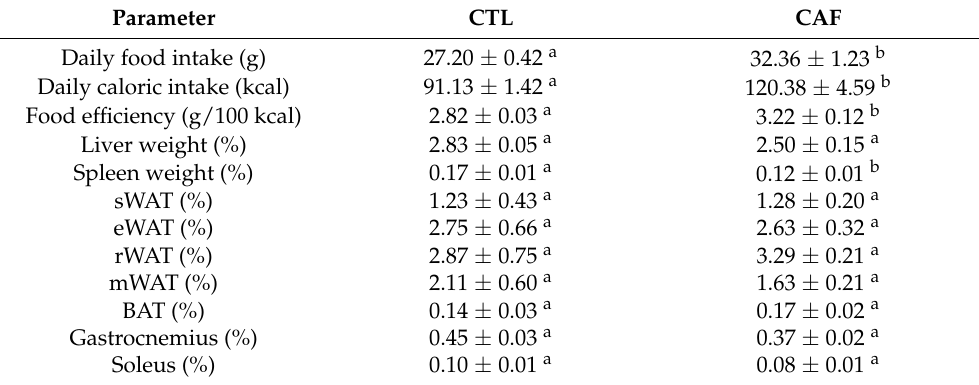
Figure 1. Effect of cafeteria diet on body weight during fifteen weeks in male Wistar rats. All the results are expressed as mean ± standard error ( n = 5 per group). Statistical analysis was performed using Student’s t test for two independent samples. Mean values with different letters (a,b) show significant differences ( p < 0.05). CTL, control group; CAF, cafeteria group. Table 2. Food intake (g and kcal), food efficiency and biometric parameters in male Wistar rats fed a cafeteria